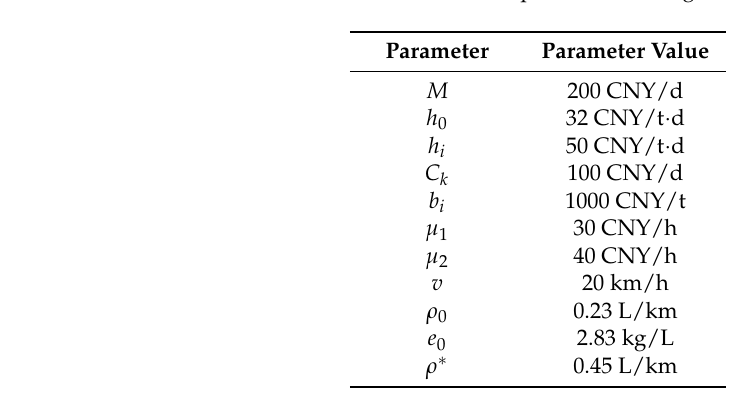
Table 5. Model parameter settings.